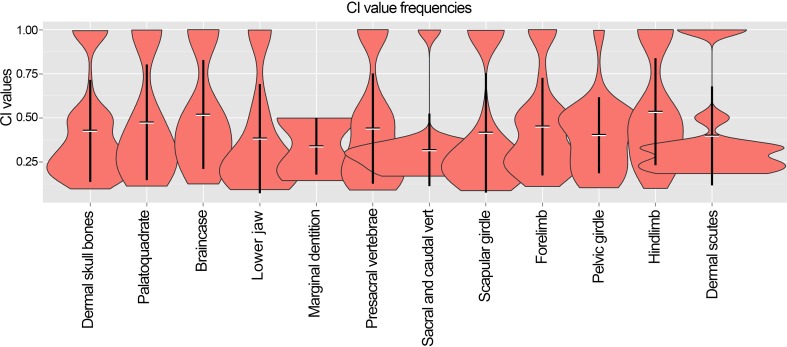
Violin box-plot showing the distribution, mean and standart deviation of the consistency indexes of each anatomical group in analysis 3.